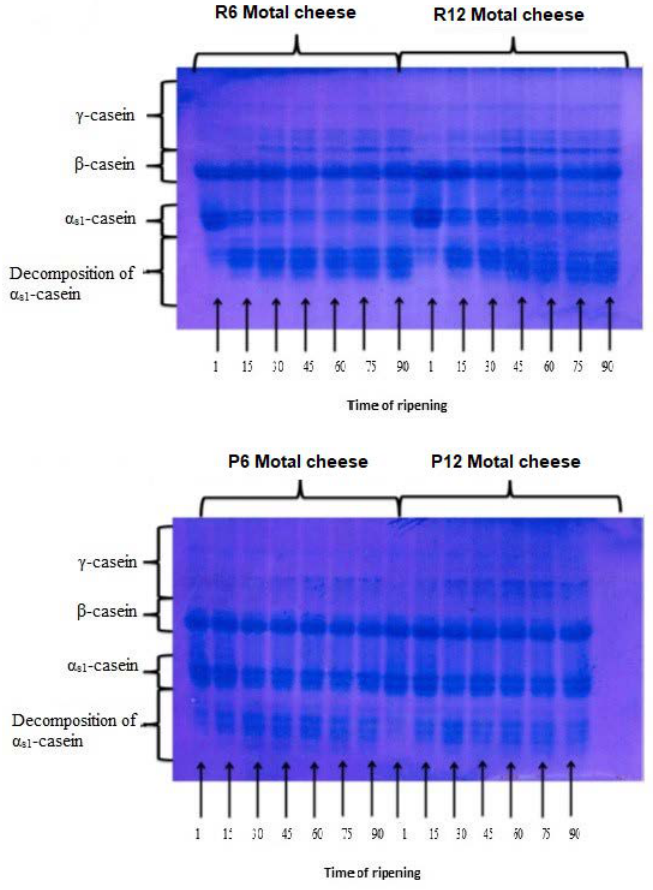
Figure 1. Electrophoretogram of insoluble phase of cheese produced from raw and pasteurized milk during ripening during ripening process.